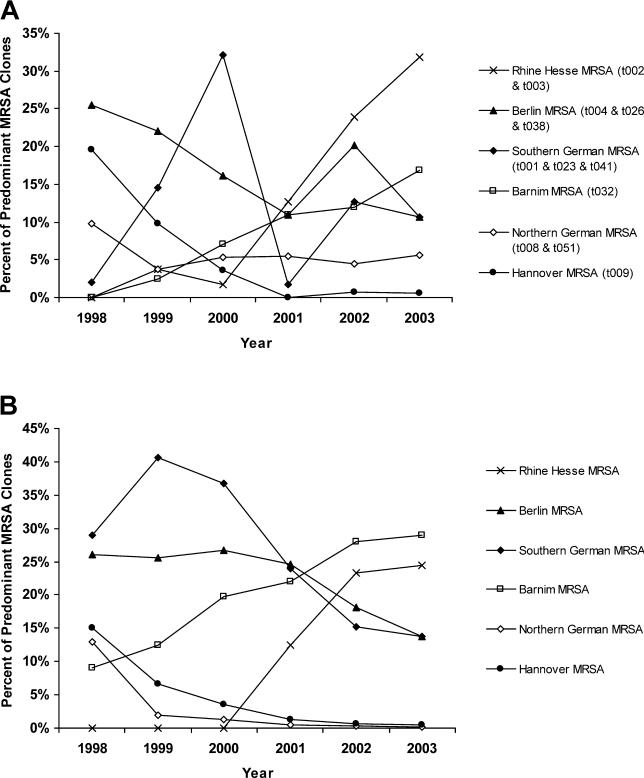
Annual Dynamics of Epidemic MRSA Clones at the UHM as Defined by spa Typing (A) and in Germany by PFGE (B) from 1998 to 2003